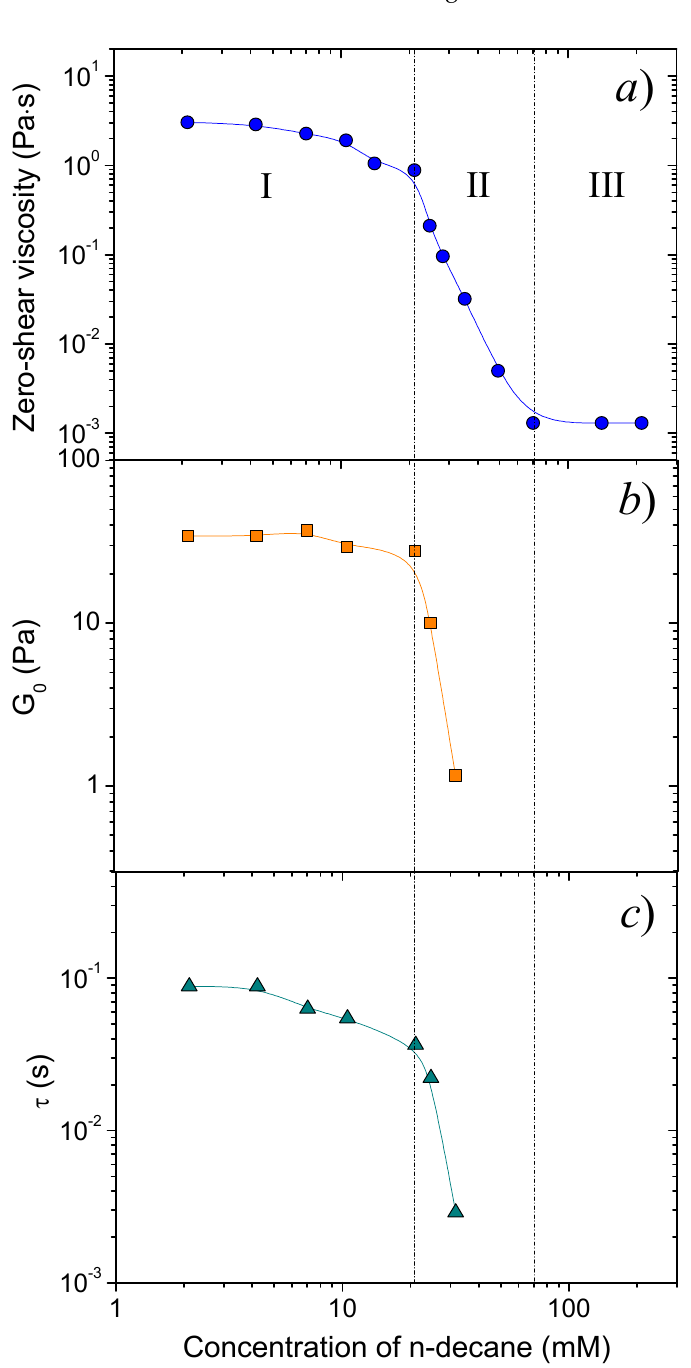
Figure 3. Dependences of zero-shear viscosity η 0 ( a ), plateau storage modulus G 0 ( b ), and terminal relaxation time τ ( c ) on n-decane concentration for 117 mM C8TAB and 78 mM potassium oleate